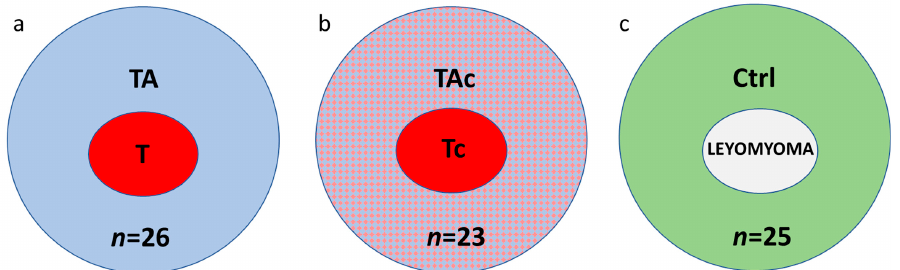
Figure 1. The studied samples from endometrial cancer ( a , b ) and cancer-free leiomyoma cases ( c ); a, paired tumor (T, red) and cancer cell-free tumor-adjacent samples (TA, blue); b, paired samples of tumors (Tc, red) and tumor-adjacent samples containing cancer cells (TAc, blue and red); c, control tissues, endometrial samples from cancer-free patients with leiomyomas (Control, Ctrl, green). Table 1. Characteristics of endometrial cancer patients. Patients with Cancer Cell-Free Tumor-Adjacent Tissues (TA), n = 26 Twenty-five endometrial samples from cancer-free patients with leiomyomas (Control, No. Patient No. Ctrl) were also collected (Figure